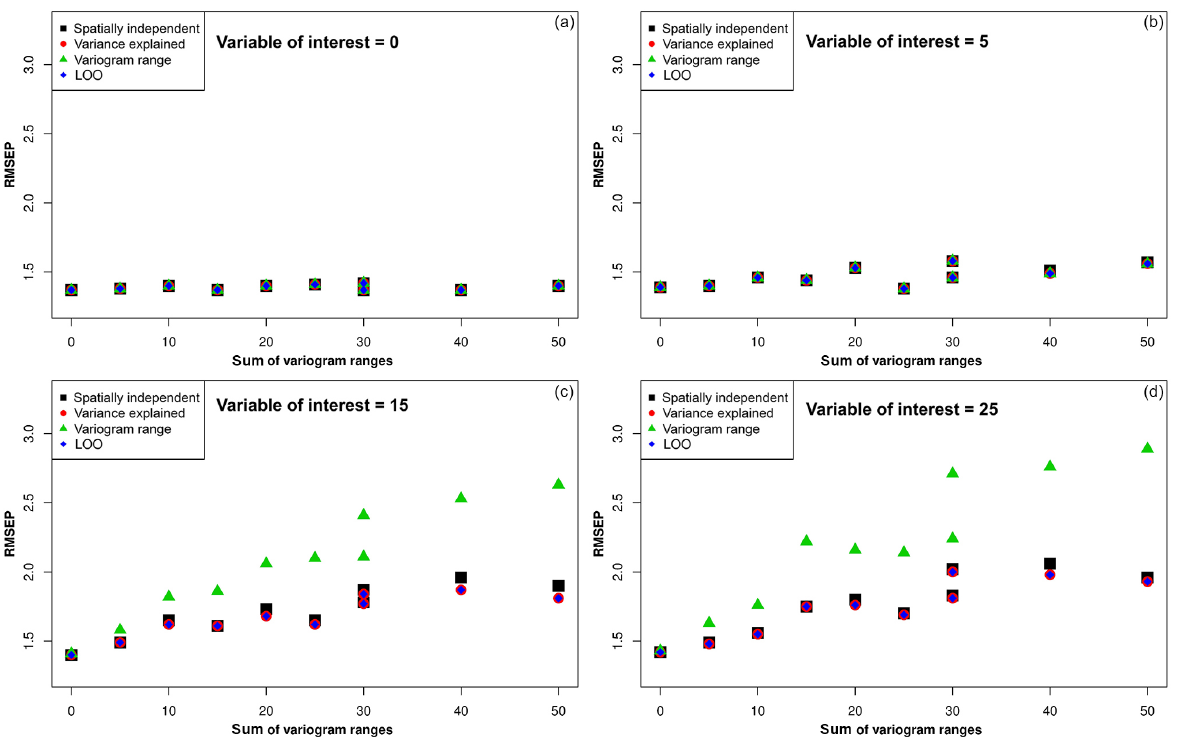
Figure 3. Comparison of root mean squared error of prediction (RMSEP) estimates using weighted averaging (WA) transfer functions as functions of autocorrelation. H -block cross-validated RMSEP and leave-one-out (LOO) cross-validated RMSEP are displayed as a function of the sum of variogram ranges of the nuisance variables, i.e. the total spatial autocorrelation increases with increasing values. H was determined using a spatially independent test set as well as the variance-explained method. RMSEPs displayed are medians of 100 replicates.